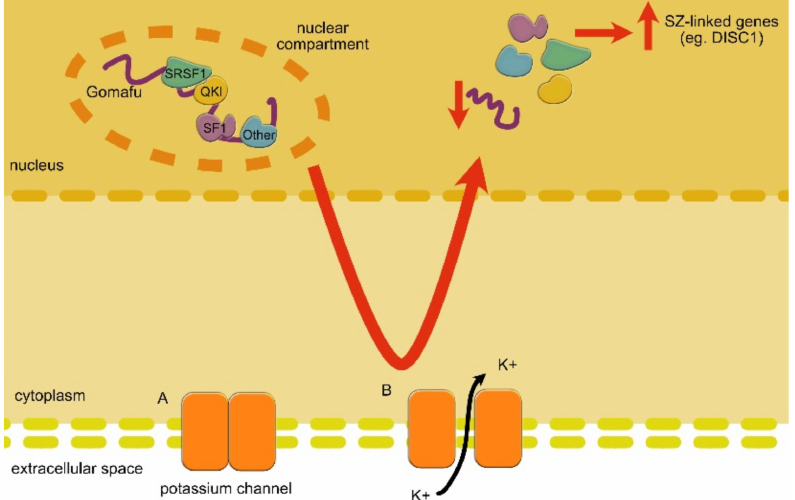
Figure 7. GOMAFU ( MIAT ) involvement in alternative splicing and SZ. When the cell is in an inactive state, the potassium channels (K+) are closed, and GOMAFU can bind several splicing factors (QKI; quaking homolog; SF1: splicing factor 1; SRSF1: serine/arginine rich SF1) involved in the expression of the SZ-related genes. In this way, it functional alternative splicing resulting in the decreased production of SZ-related proteins. When the cell becomes active, however, the ion channels open, and the influx of K+ ions leads to GOMAFU transcription downregulation (which is significantly decreased in SZ). The splicing factors are, therefore, free to act toward the alternative splicing of SZ-linked